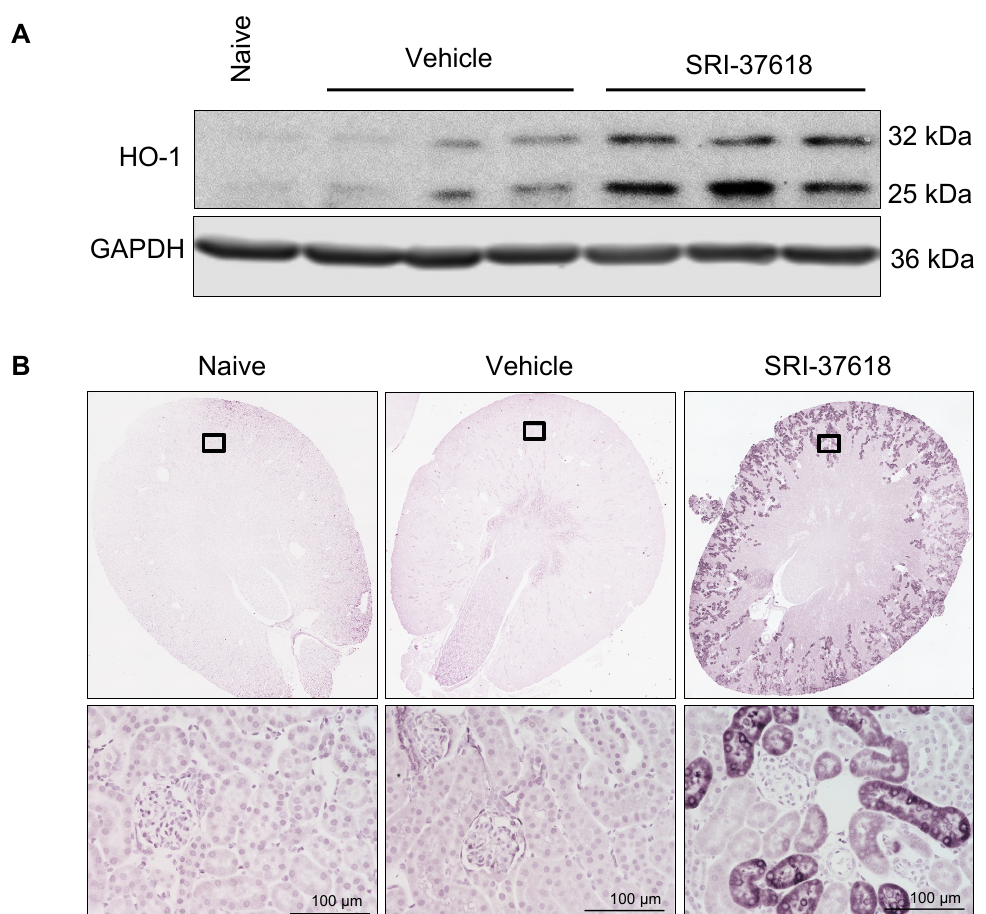
Figure 8. In vivo delivery and induction of HO-1 in the kidney assessed after 6 h of small-molecule delivery. ( A ) Western blot for HO-1 in whole kidney lysates of mice injected intraperitoneally with 60 mg/kg of small molecule SRI-37618 formulated as a free base in a vehicle solution of 5% DMSO, 5% solutol in saline. Membranes were stripped and probed for GAPDH. Each lane represents an individual mouse (n = 3) ( B ) Representative immunohistochemistry for HO-1 in kidney sections of mice 6 h after intraperitoneal injection with 60 mg/kg SRI-37618 prepared as a salt solution capable of being dissolved and delivered in saline vehicle. Top panel showcases entire kidney section (20×); the cortical insets are displayed in the lower panel. Scale bar = 100 µm.